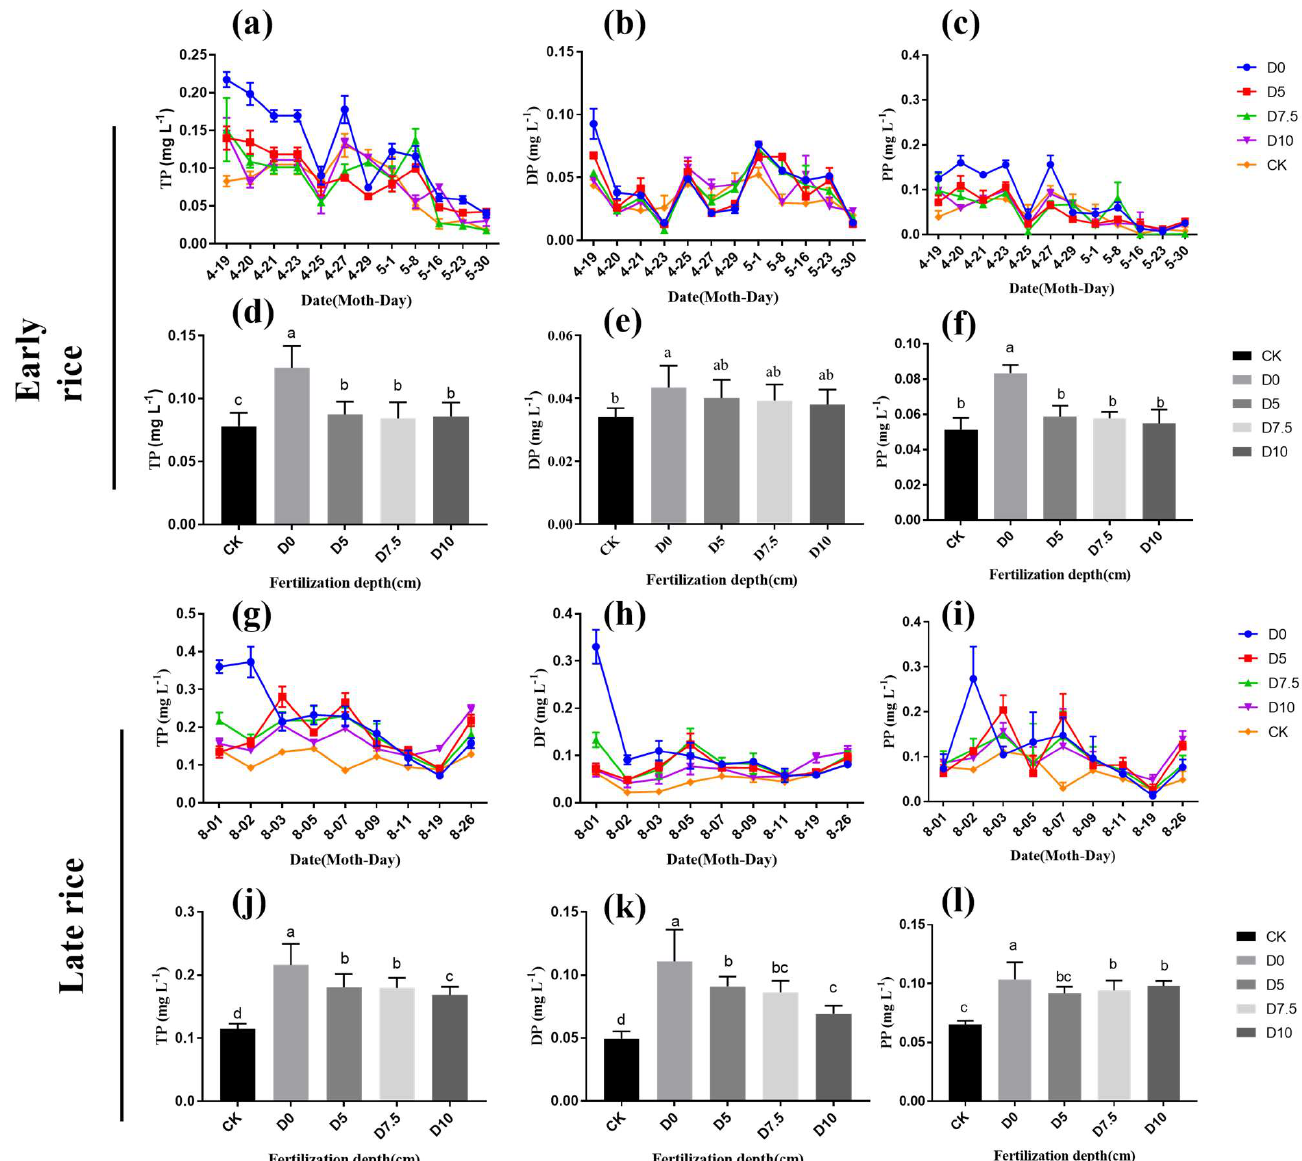
Figure 8. Concentration changes of different forms of phosphorus in surface water under different fertilization-depth treatments. CK: no fertilizer; D0: surface spreading; D5: 5 cm side-deep fertilization; D7.5: 7.5 cm side-deep fertilization; D10: 10 cm side-deep fertilization. Different lowercase letters in the figure indicate significant difference among treatments at p = 0.05 (LSD). ( a – c ): Dynamic change of different nitrogen forms in early rice; ( d – f ): Average concentration of different nitrogen forms in early rice; ( g – i ): Dynamic change of different nitrogen forms in late rice; ( j – l ): Average concentration of different nitrogen forms in early rice.